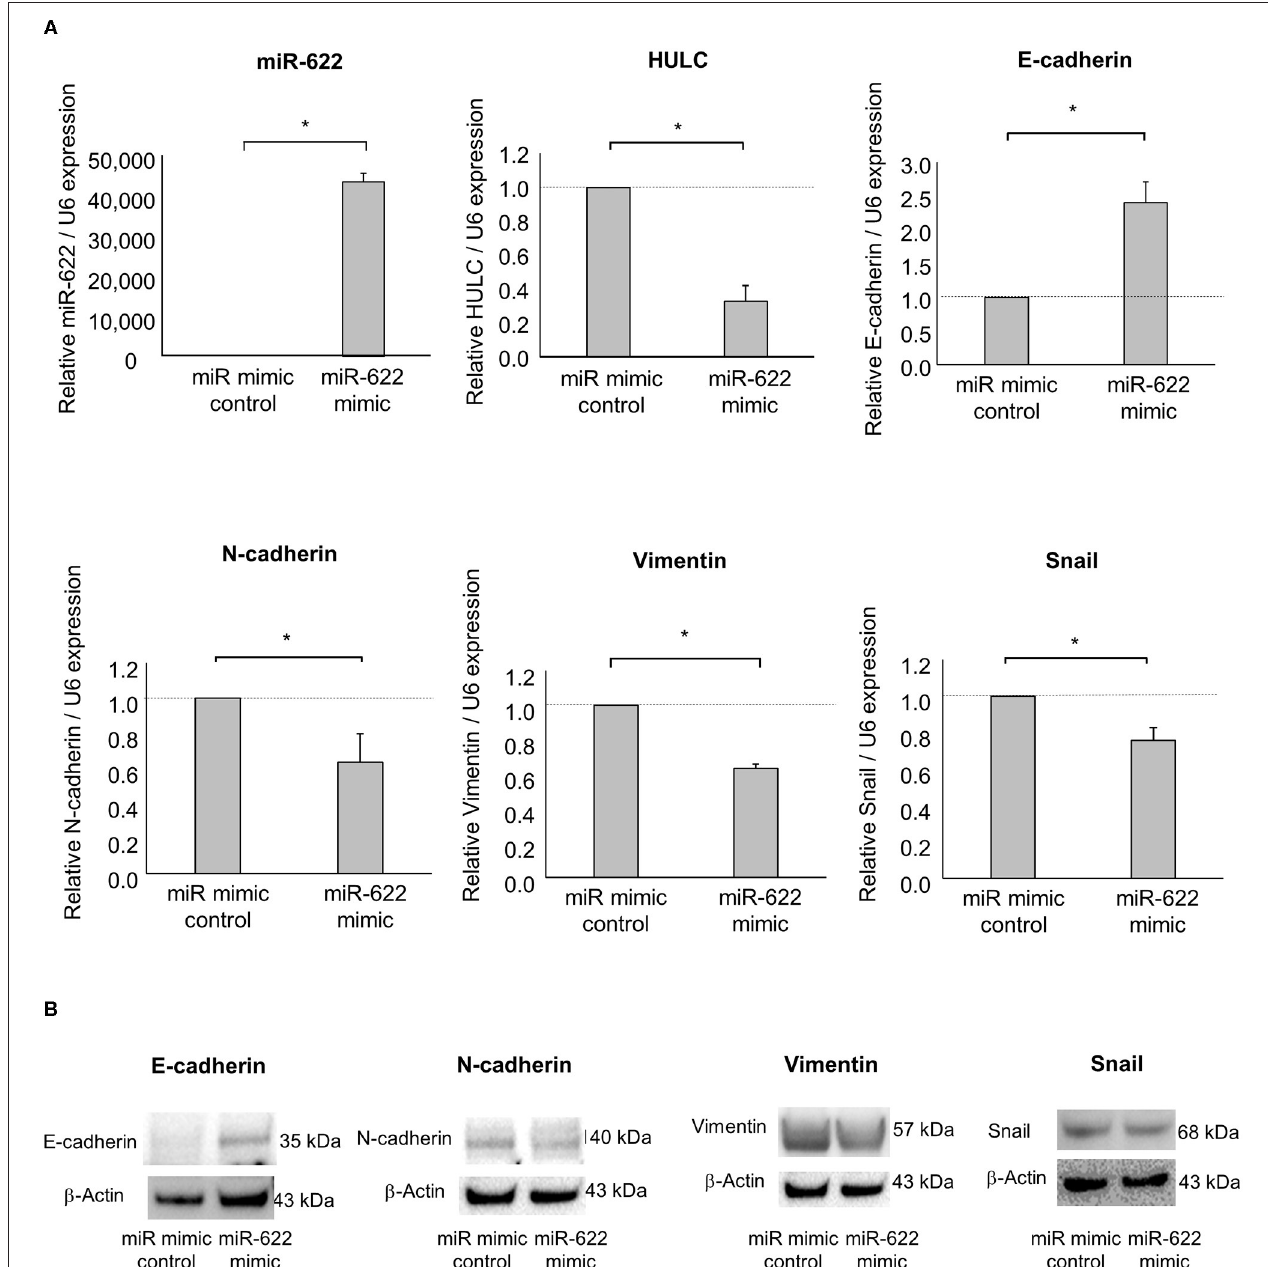
FIGURE 2 | Effect of miR-622 overexpression on EMT in PDAC cells. Panc-1 cells were transfected with 12.5nM miR-622 or the control mimic. (A) After 48h, RNA was extracted and expression of miR-622, HULC, E-cadherin, N-cadherin, vimentin, and Snail was assessed by qRT-PCR. Bars are the means ± SEM of three independent experiments. * P < 0.05. (B) After 72h, protein was extracted, and western blotting for E-cadherin, N-cadherin, vimentin, and Snail was performed. Protein levels were normalized to that of β